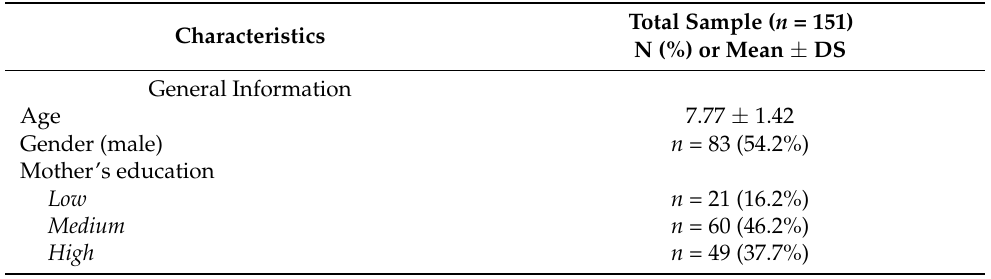
Table 1. Baseline characteristics of the